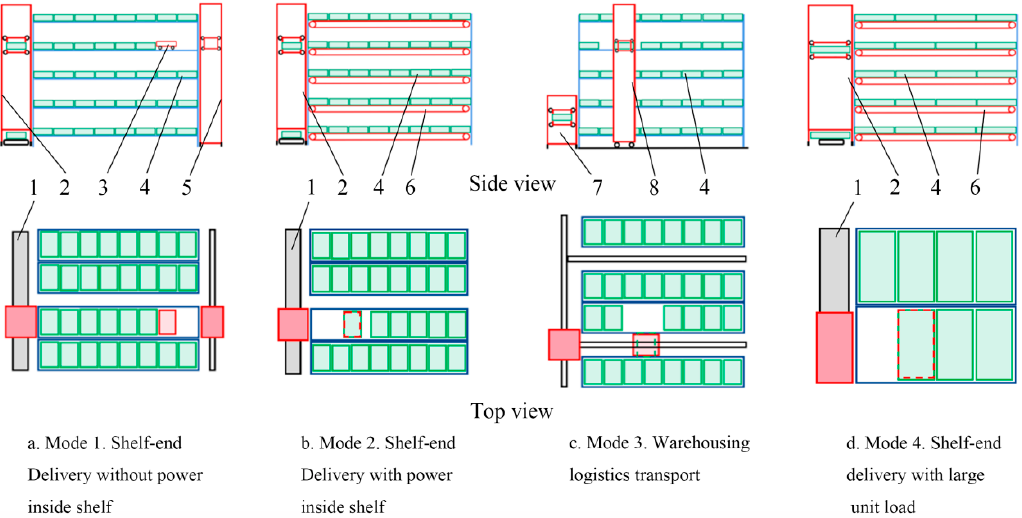
Figure 3. Four types of logistics transport systems for cultivation units in plant factory. 1. Ground convey line; 2. Input and output lift cart (IOLC); 3. Guided pushing vehicle (GPV); 4. Vertical cultivation shelf; 5. GPV lift cart (GPVLC); 6. Convey system of cultivation shelf ( CSCS); 7. End delivery lift cart (EDLC); 8. Guided delivering vehicle (GDV).